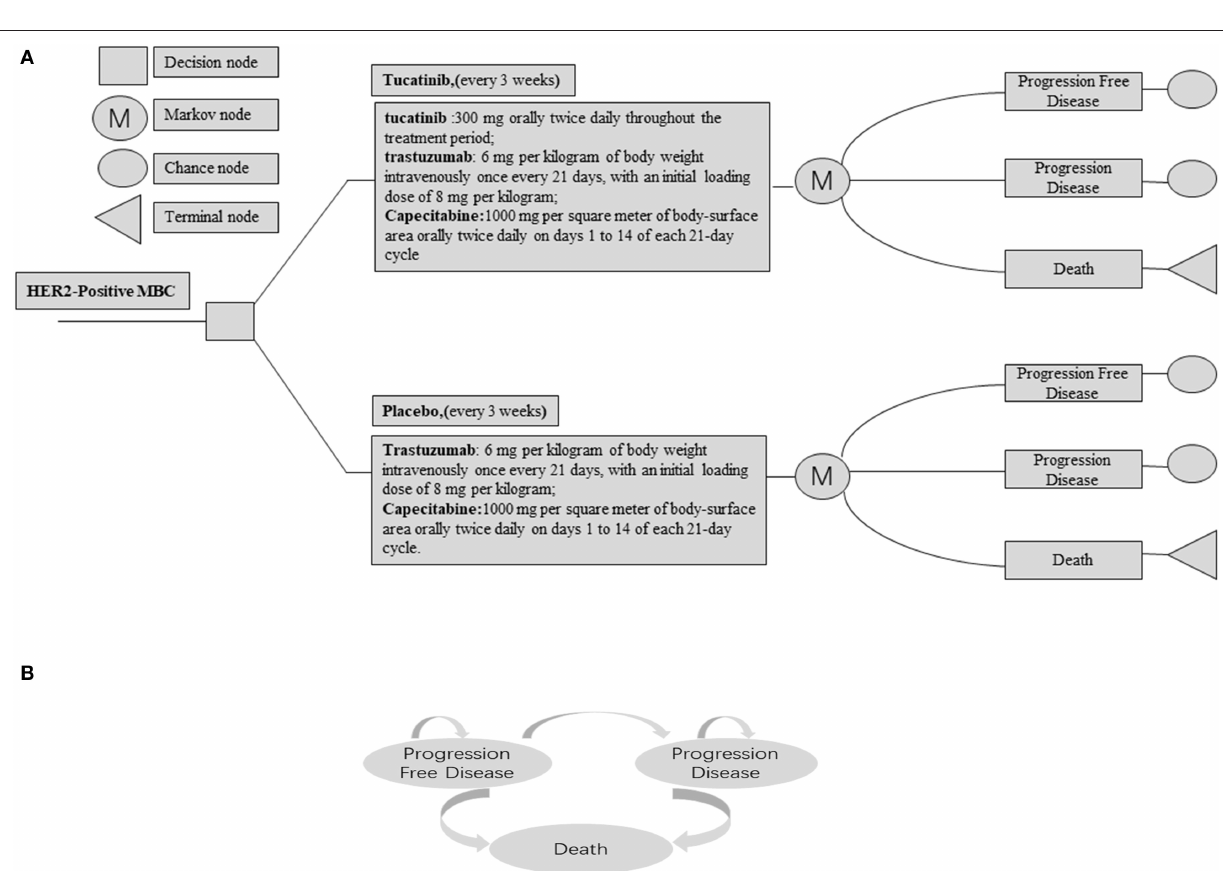
FIGURE 1 | (A) Abbreviated decision tree and Markov model used to compare two strategies for treating patients with HER2-Positive Metastatic Breast Cancer. (B) The influence diagram shows a network of three health states linked by transitional